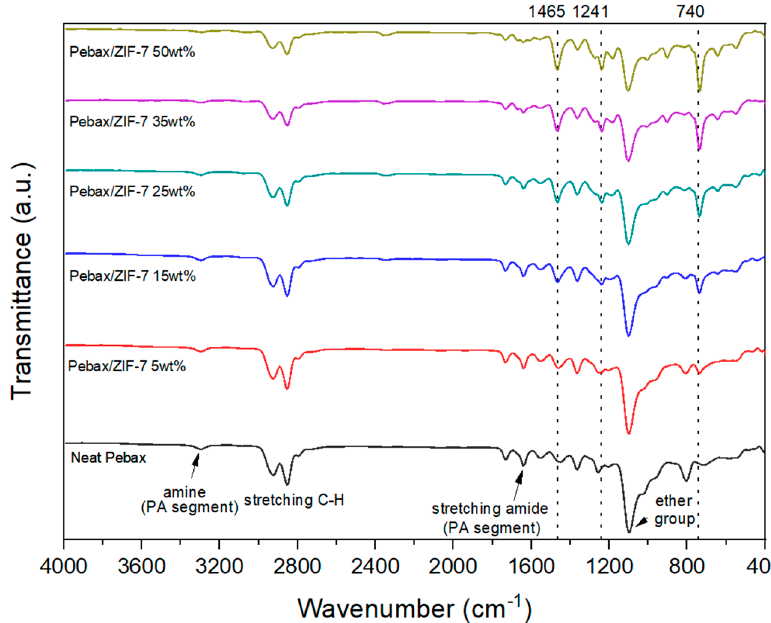
Figure 6. FT − IR spectra of Pebax ‐ 2533/ZIF ‐ 7 composite membranes.